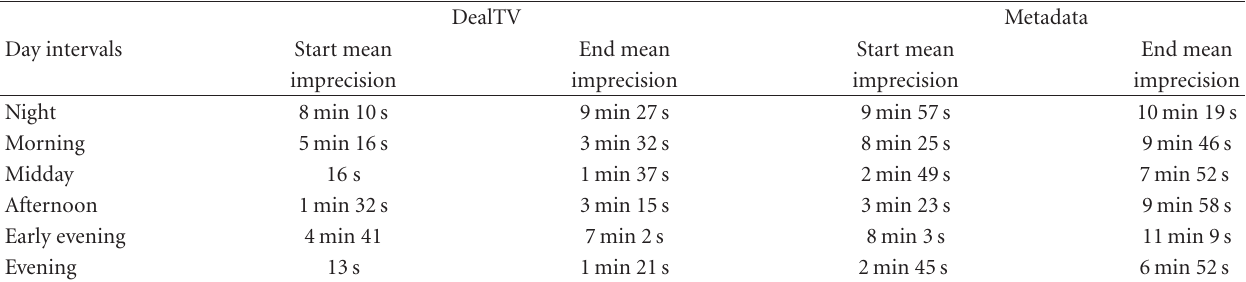
Table 8: Accuracy of extracted programs by DealTV, comparison with metadata. DealTV Metadata